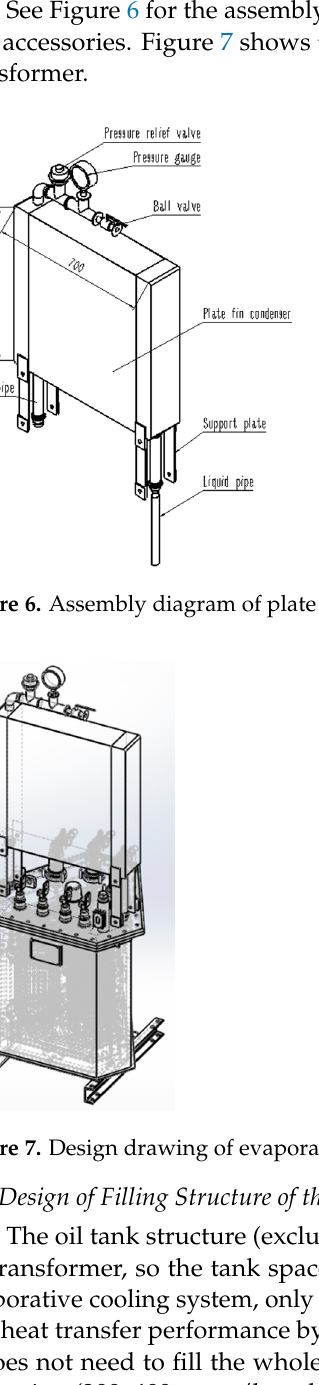
Figure 5. Condenser design drawing.